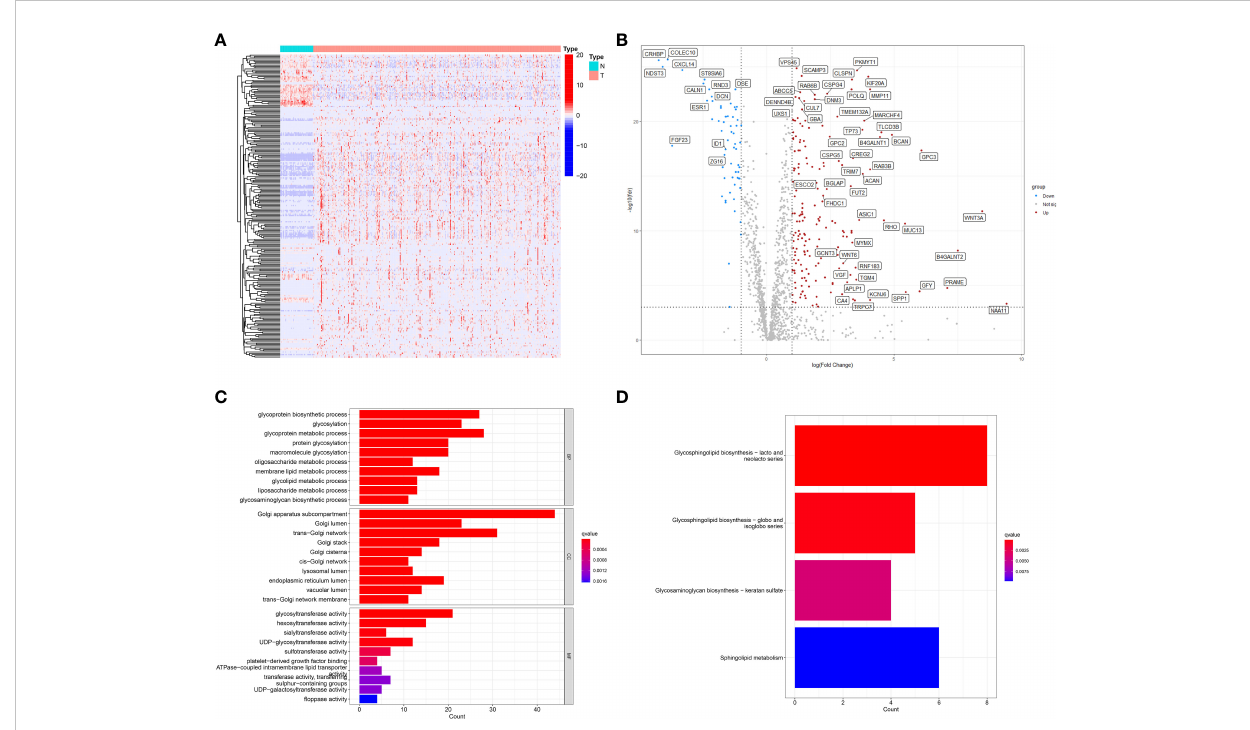
FIGURE 2 Identi fi cation of differentially expressed GARGs in HCC. (A) The heatmap. (B) The volcano map. (C) Gene ontology (GO) analysis of differentially expressed GARGs. (D) Kyoto Encyclopedia of Genes and Genomes (KEGG) analysis of differentially expressed GARGs.